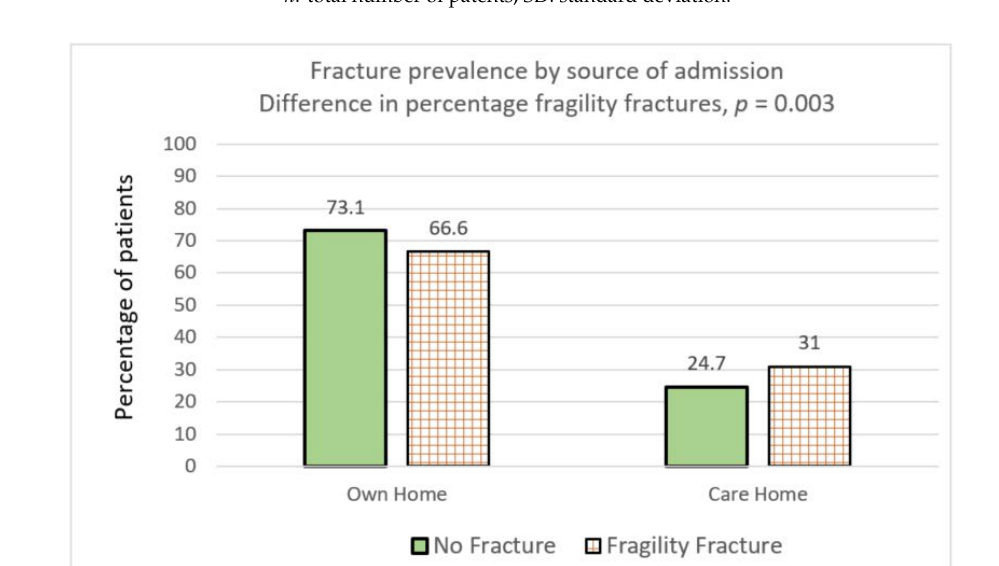
Figure 1. Prevalence of fragility fracture in the community and care home in patients with dementia.